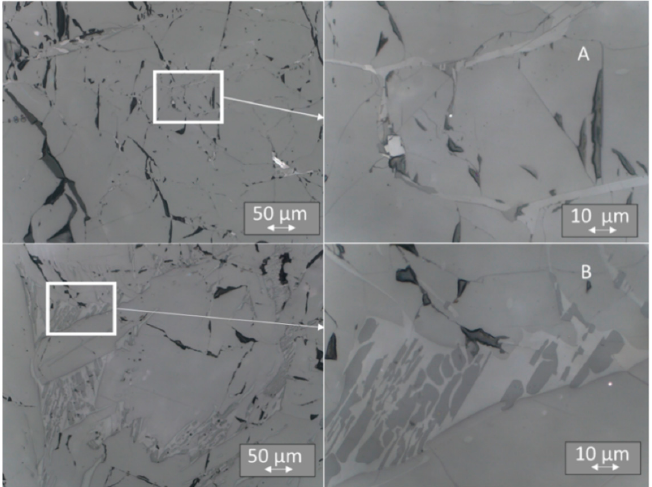
Figure 14. Microstructure of LMP doped with 1.2-mol% Tm and 10-mol% B. Top panels ( A )—sample No. 5 at a magnification of 200× (on the left) and 1000× (on the right); bottom panels ( B )—sample No. 18 at a magnification as above. The inset on the left has been further magnified on the right.